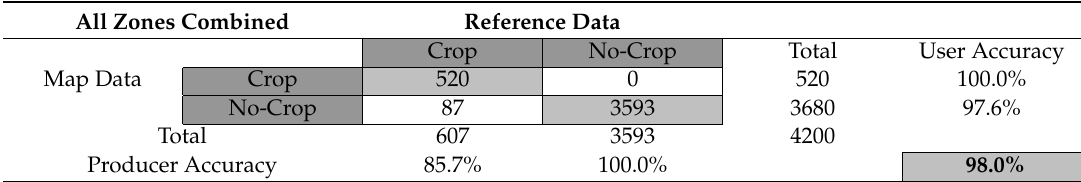
Table 2. An overall accuracy matrix for the cropland extent map of